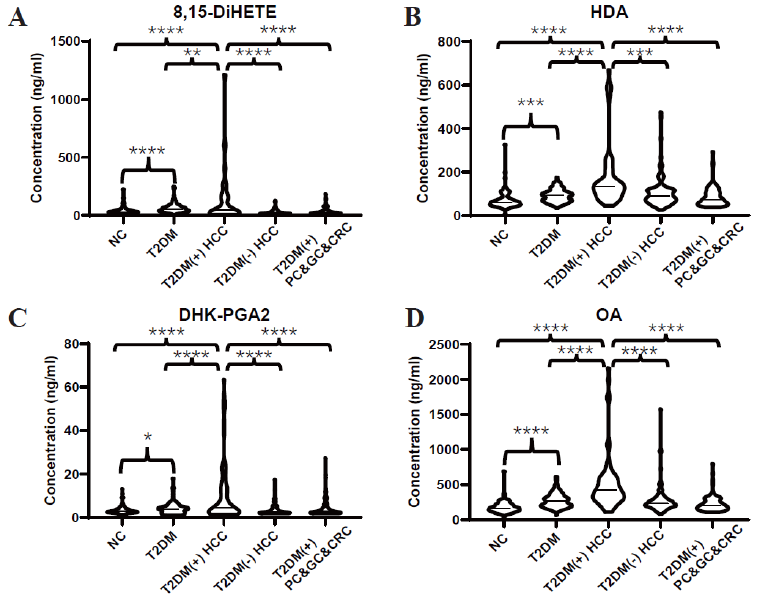
Figure 3. Expression profiles of several dysregulated serum lipids in the test set. ( A – D ) represent the levels of serum 8,15-DiHETE, HDA, DHK-PGA2 and OA in the test set, respectively. Student’s t test or Mann-Whitney U test was applied. NC, normal control; T2DM, type 2 diabetes mellitus; HCC, hepatocellular cancer; CRC, colorectal cancer; PC, pancreatic cancer; GC, gastric cancer. **** p value < 0.0001; *** p value < 0.001; ** p value < 0.01; * p value < 0.05.